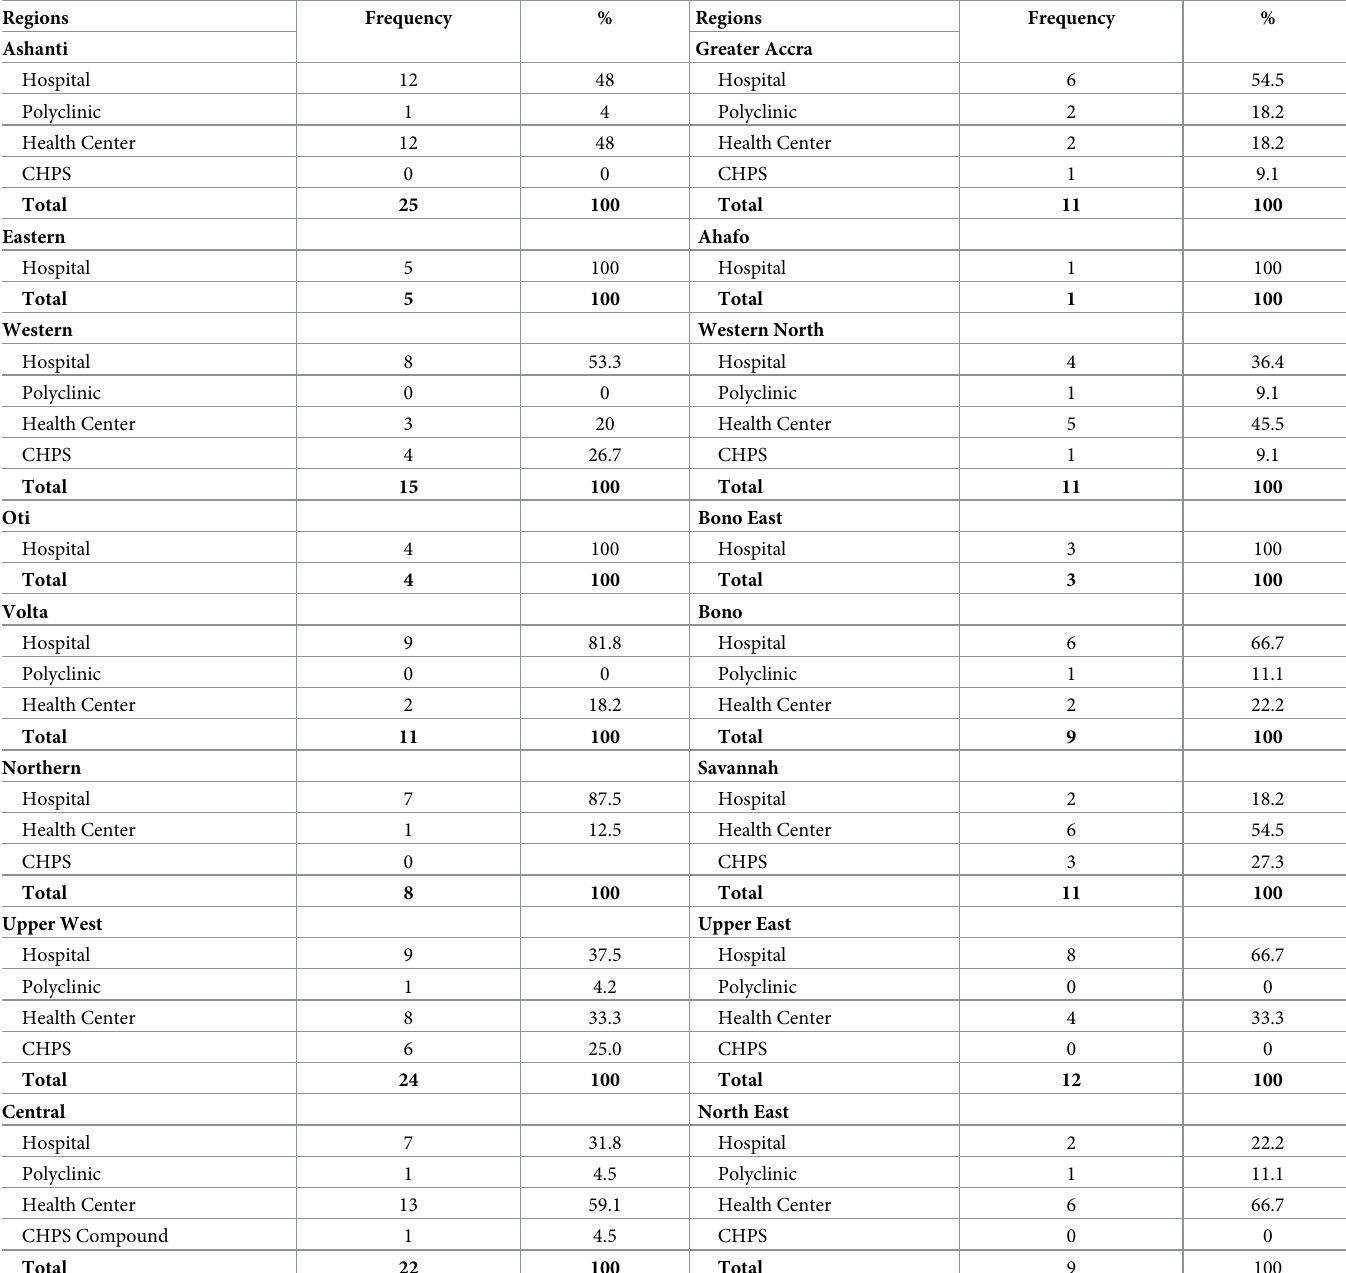
Table 1. Number and type of health facilities across the